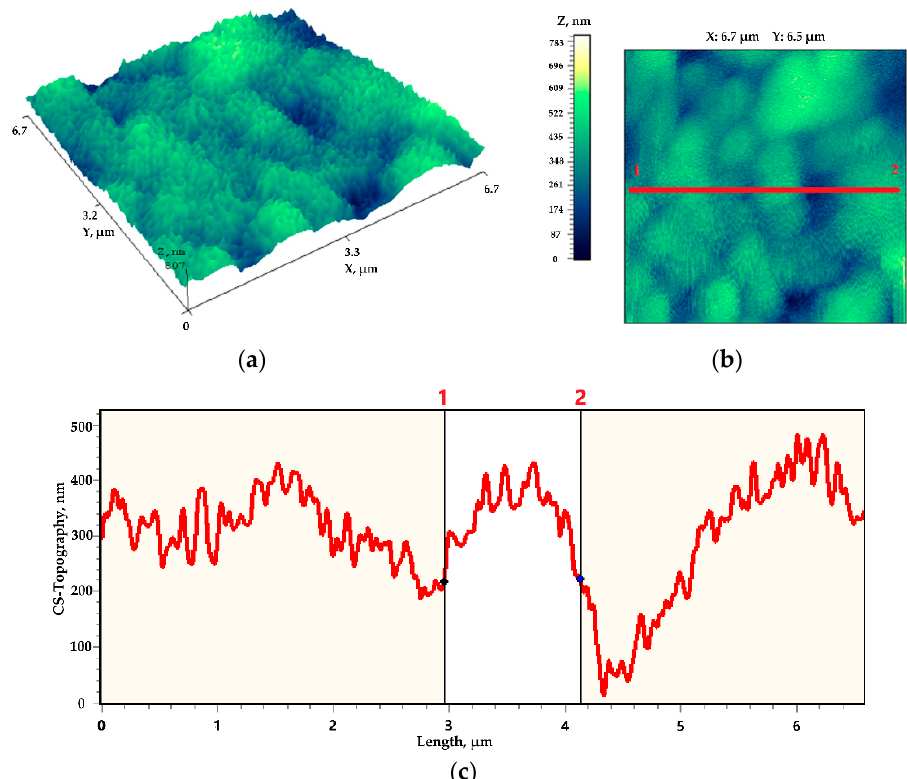
Figure 2. AFM image of 3D ( a ) and 2D ( b ) topography with normalized Z (nm scale), and profilogram of pp-HMDS film at deposition time of 60 s ( c ).